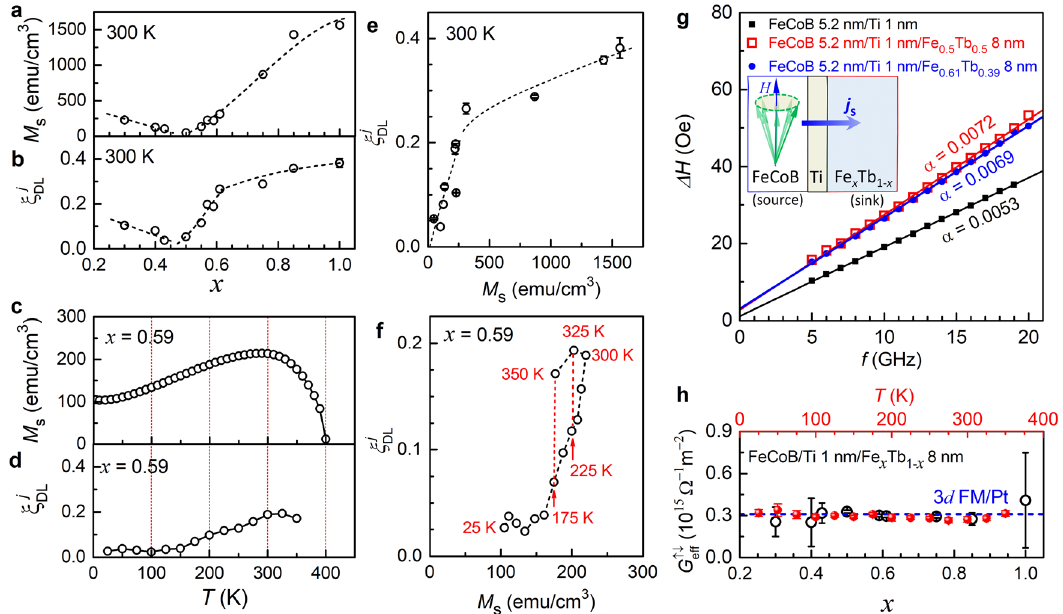
Fig. 2 | Spin-orbit toque and spin-mixing conductance. a , b Saturation magne- tization ( M s ) and Damping-like SOT ef fi ciency per unit current density ( ξ j DL ) for Pt 0.75 Ti 0.25 /Fe x Tb 1- x with different Feconcentration( x ) at300K. c , d M s and ξ j DL for thePt 0.75 Ti 0.25 /Fe 0.59 Tb 0.41 atdifferenttemperatures. e ξ j DL vs M s forthePt 0.75 Ti 0.25 / Fe x Tb 1- x with different Feconcentration ( x ) at300K. f ξ j DL vs M s for the Pt 0.75 Ti 0.25 / Fe 0.59 Tb 0.41 at different temperatures. g Frequency dependence of ferromagnetic resonance linewidth ( Δ H ) of the FeCoB layer in FeCoB (5.2nm)/Ti (1nm), FeCoB (5.2nm)/Ti (1nm)/Fe 0.5 Tb 0.5 (8nm), and FeCoB (5.2nm)/Ti (1nm)/Fe 0.61 Tb 0.39